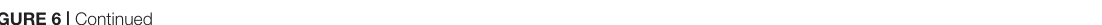
FIGURE 6 | Continued indicates the oocyte edge. Scale bar = 20 µ m. (B) Percentages of MII oocytes with altered mitochondrial distributions. (C) Representative images of mitochondrial membrane potentials. Red, high (cid:49)(cid:57) m; Green, low (cid:49)(cid:57) m. Scale bar = 100 µ m. (D) Ratio of red to green fluorescence intensities from (C) . (E) Representative images of ROS generation determined by DCFH-DA fluorescence (green). Scale bar = 100 µ m. The square white frame indicates the region shown in detail, and the circular white frame indicates the oocyte edge. (F) Quantification of ROS fluorescence intensities. (G) Representative images of early stage apoptosis in MII oocytes. No green fluorescence signals were observed in oocyte membranes, indicating no apoptosis (upper panel) . Oocytes undergoing early apoptosis were characterized by